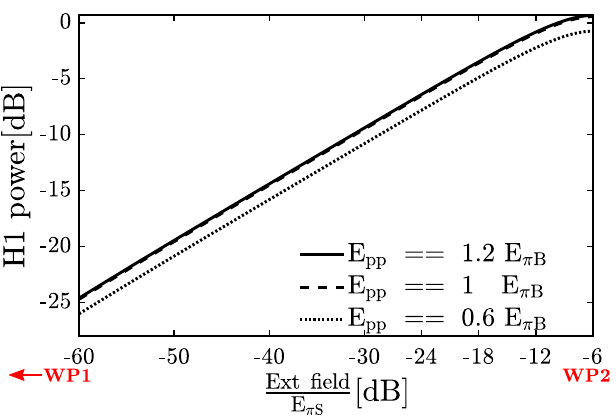
Figure 10. H1 power as a function of the incident electric field for fixed values of the modulation amplitude.